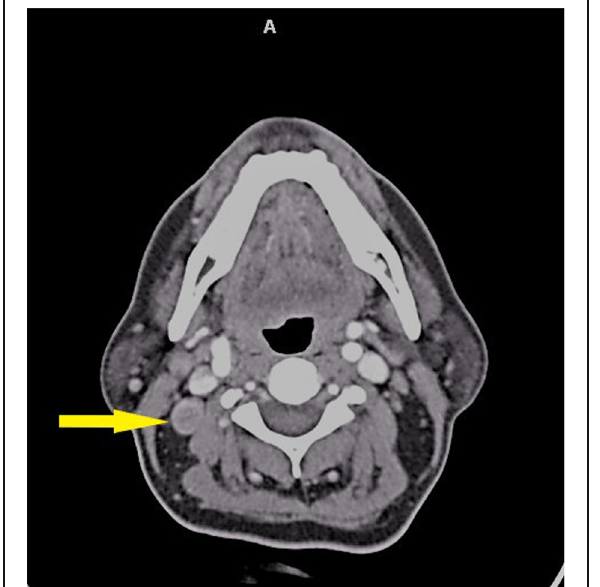
Fig. 3 Contrast enhanced computerised tomography shows an enlarged rounded lymph node of size 1.5 cm × 1.2 cm × 2 cm is